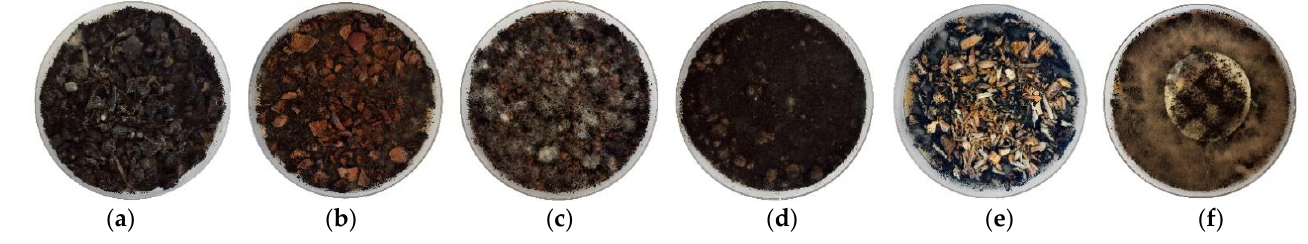
Figure 9. Mould growth (test with culture media) after four weeks: ( a ) grape press waste; ( b ) hazelnut shells; ( c ) olive press waste; ( d ) spent coffee grounds ( e ) wood chips; ( f ) filter paper control.